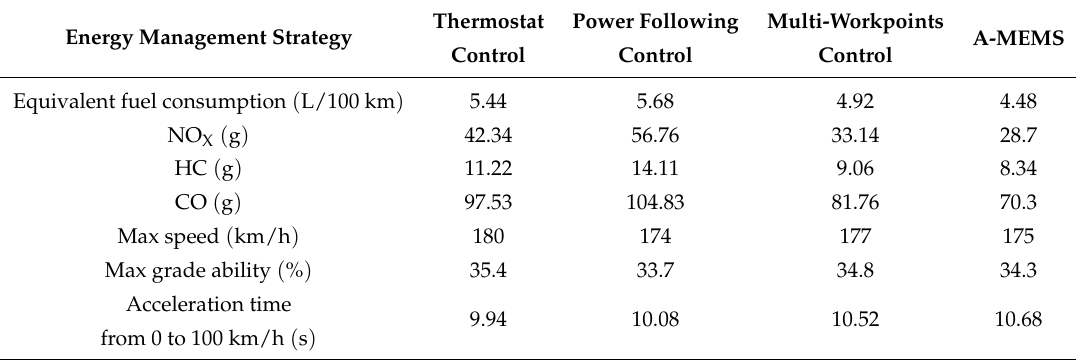
Table 10. Parameter optimization results of five typical driving